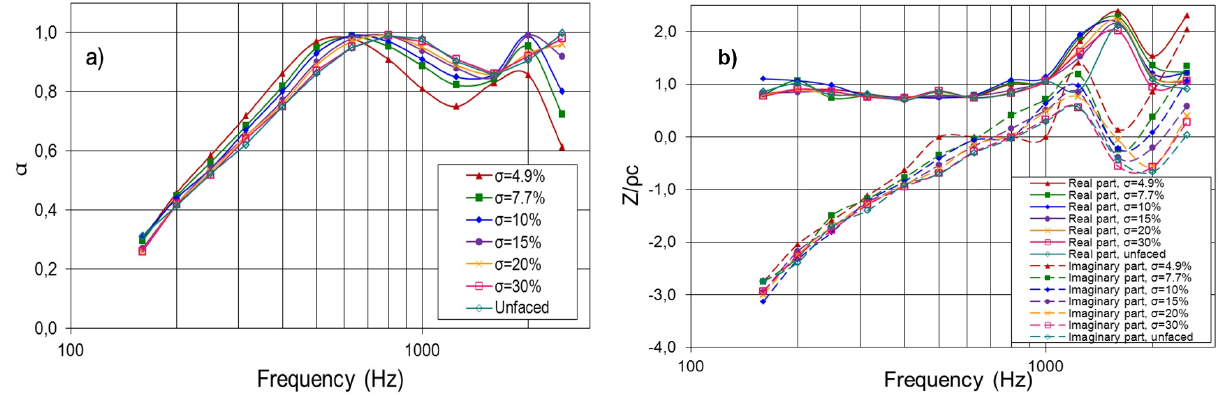
Figure 8: Absorption coeflcient (a) and normalized acoustic impedance (b) curves for samples faced with different perforated plates